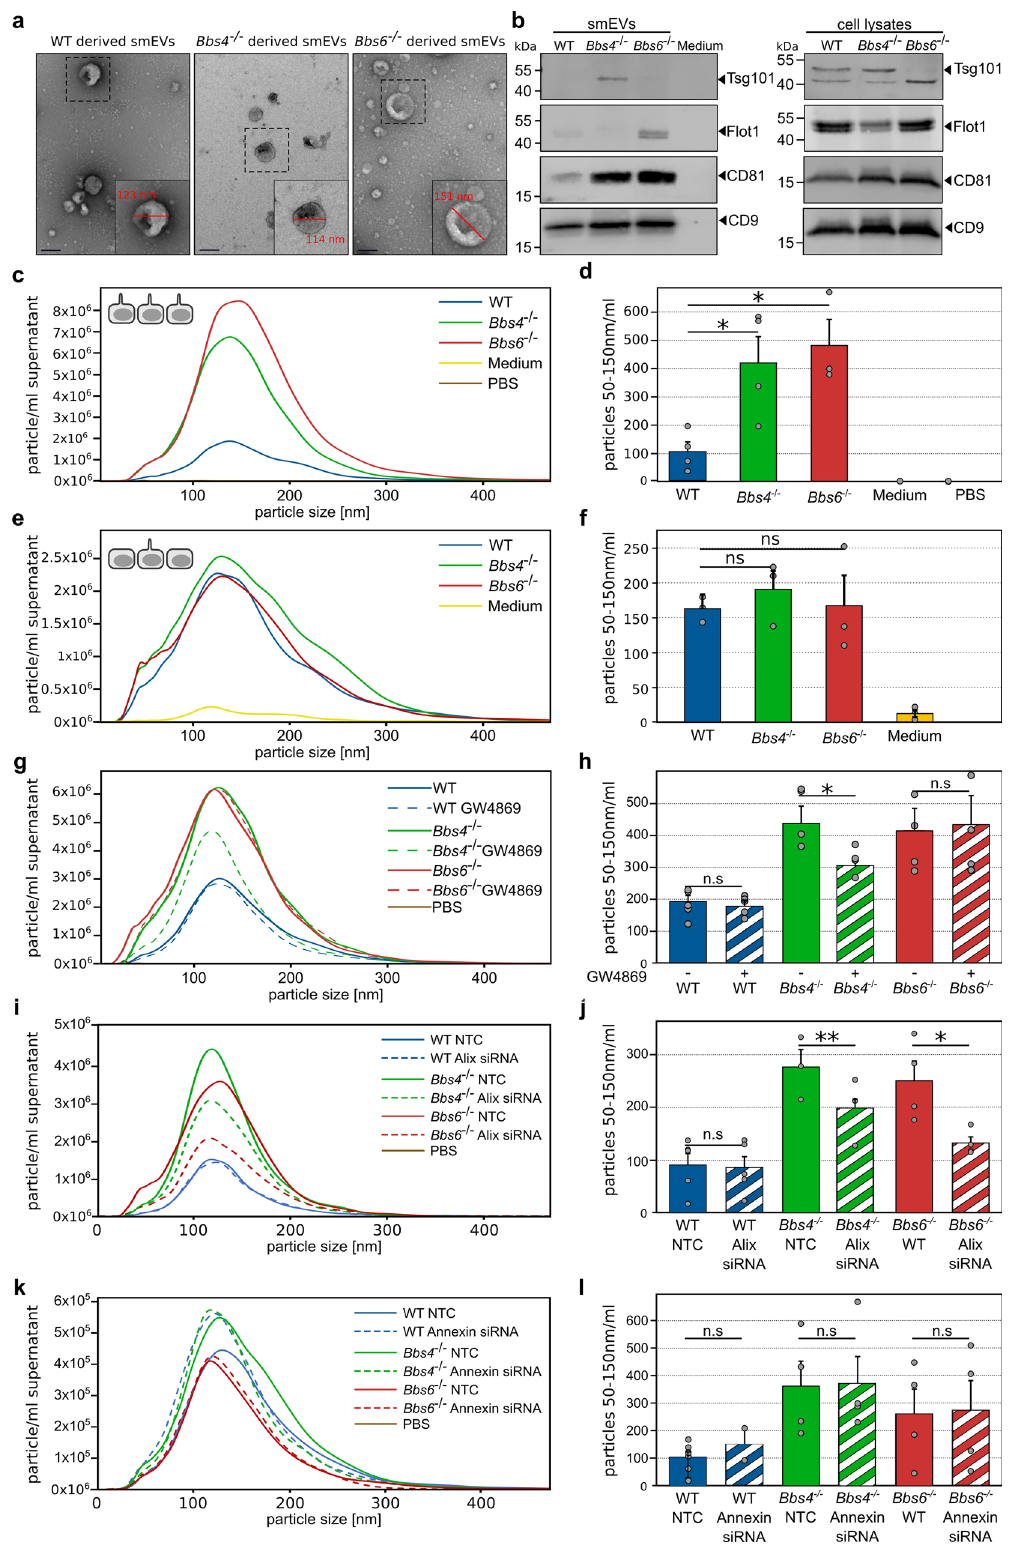
method of preparation enriched for EVs. We noticed distinct differences in protein composition between the smEV pellet from control and ciliary mutant cells. Tsg101, a protein important during sorting endocytic cargo into MVBs 51,52 , could only be detected in smEVs secreted from Bbs4 − / − cells. Flotillin-1, a